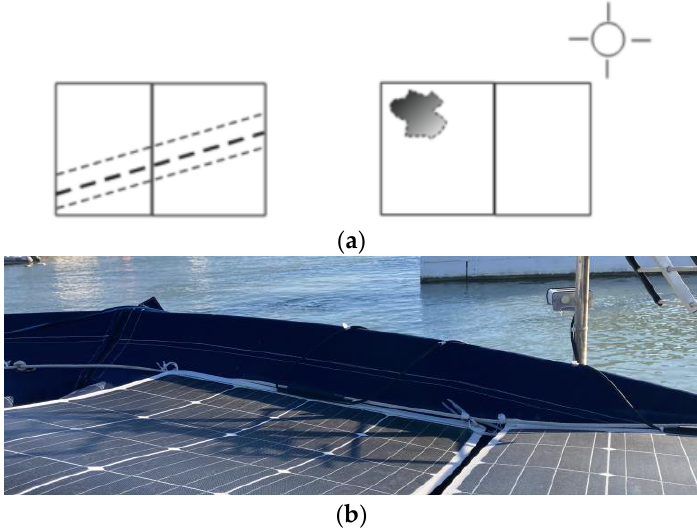
Figure 25. Shading of a weather station antenna: ( a ) simplified diagram; ( b ) actual assembly.